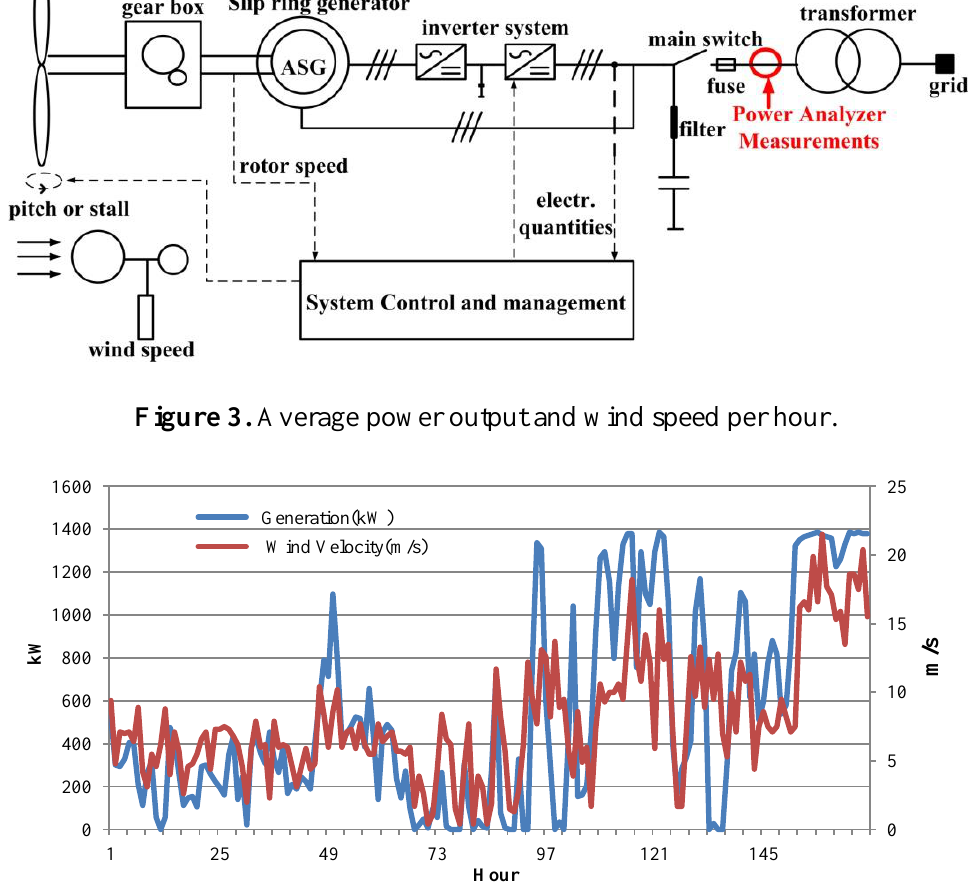
Figure 4. Voltage and current harmonic spectra at wind speed 9.2 m/s. ( a ) Voltage harmonic spectra; ( b ) Current harmonic